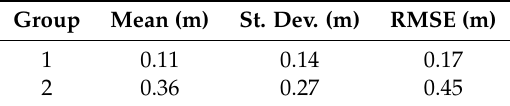
Table 4. Statistics of the differences between UAS and manual measurements in 2016. Results are separated between areas with significantly smaller errors (Group 1, courses A, B, E, F, I, L, M and N—84 samples) and areas with larger errors (Group 2, courses C, D, G, and H—51 samples). Group Mean (m) St. Dev. (m)